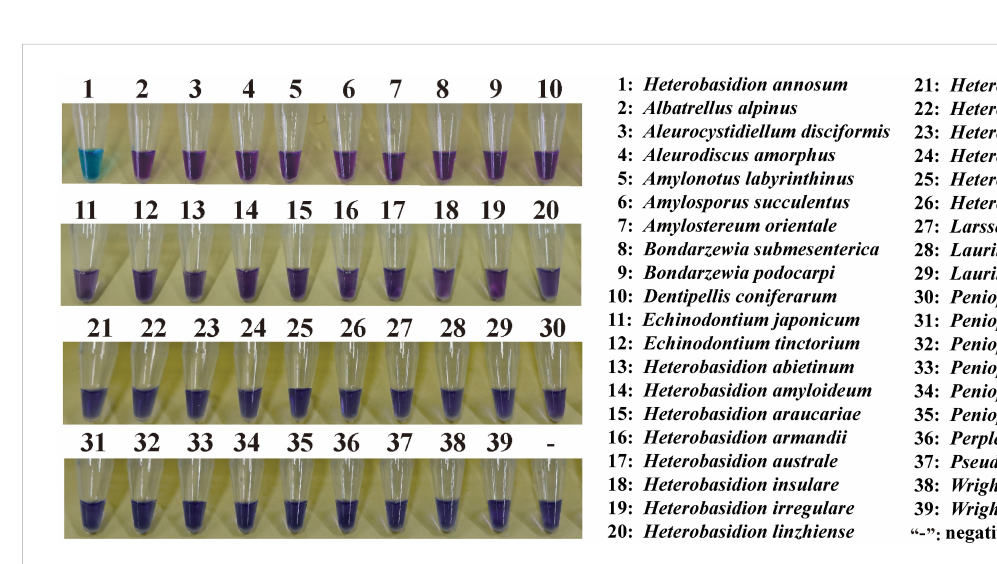
FIGURE 3 Ability of the LAMP assay to distinguish H. annosum from other species in Russulales. “ - ” : negative